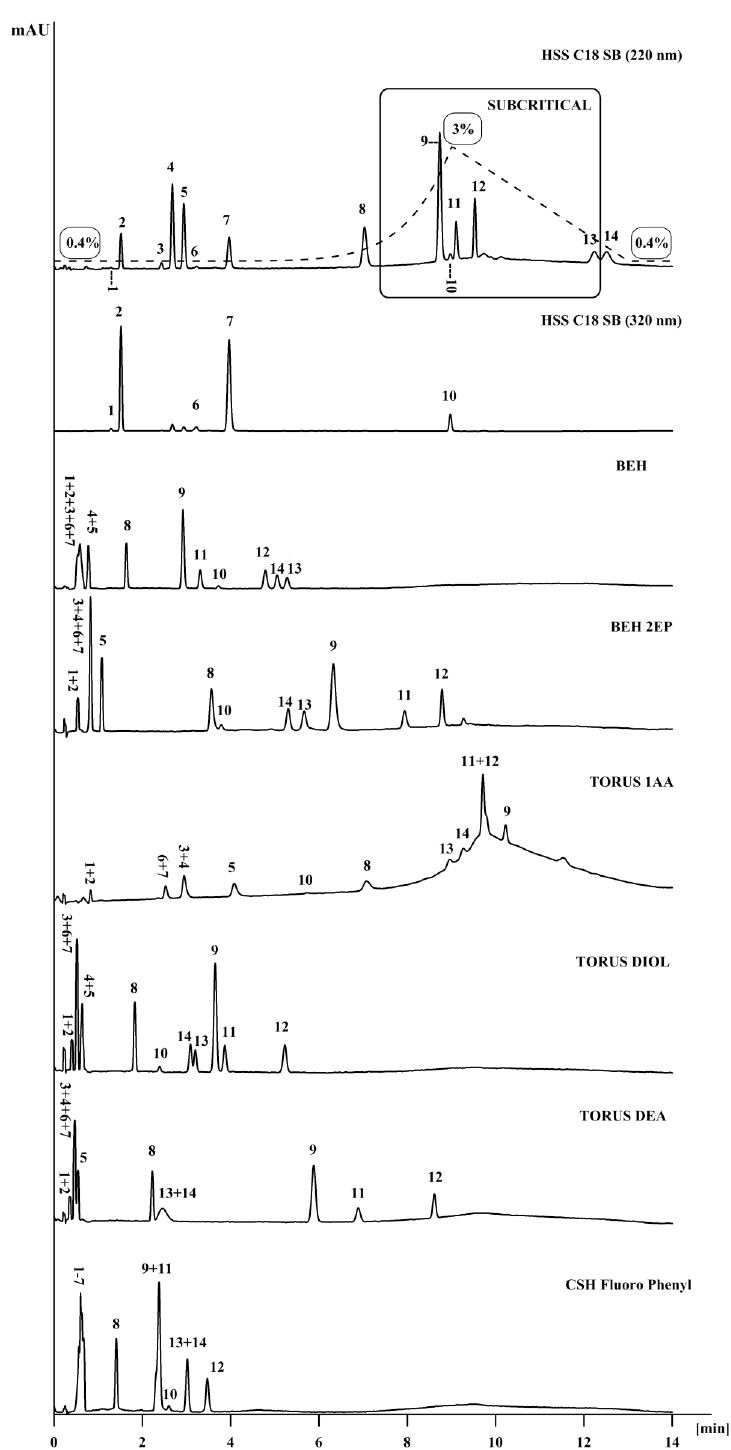
Figure 1. The separation of fat-soluble vitamins in different stationary phases. Mobile phase: CO 2 /methanol; gradient mode: initial 0.4% B, held for 1 min., increase to 3% B in 8 min., back to 0.4% B in 4 min.; flow rate: 2.3 mL/min; column temperature: 35 ◦ C; ABPR (atmospheric back pressure regulator): 12.41 MPa; dash lines (- - -) show the gradient program, percentage of methanol in the mobile phase. (11-Z) cis -retinyl acetate (1), trans -retinyl acetate (2), cis -phylloquinone ( cis -K 1 ) (3), trans -phylloquinone ( trans -K 1 ) (4), menaquinone-4 (K 2 -MK4) (5) cis -retinyl palmitate (6), retinyl palmitate (7), α -tocopherol (8), β -tocopherol (9), retinol (10), γ -tocopherol (11), δ -tocopherol (12), ergocalciferol (D 2 ) (13) and cholecalciferol (D 3 )